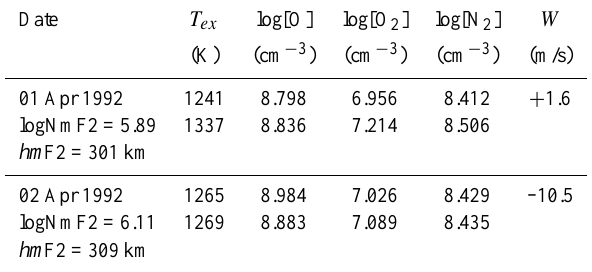
Fig. 7. Diurnal variations of NmF2 and hm F2 observed at Millstone Hill for winter and summer conditions during solar maximum. The selected days il- lustrate well-pronounced winter (WW) and summer (SS) types of diurnal vari- ations.